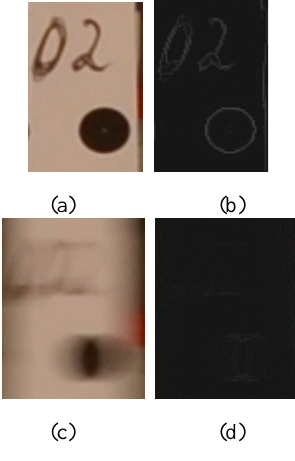
Figure 1. Example of a photogrammetric target. (a) Sharp image without any camera movement during image exposure. (b) The target is easy identifiable due to the well-defined edge between black and white. (c) Image blurred due to motion during image exposure. (d) The target is difficult to identify due to the difficulty to define the target